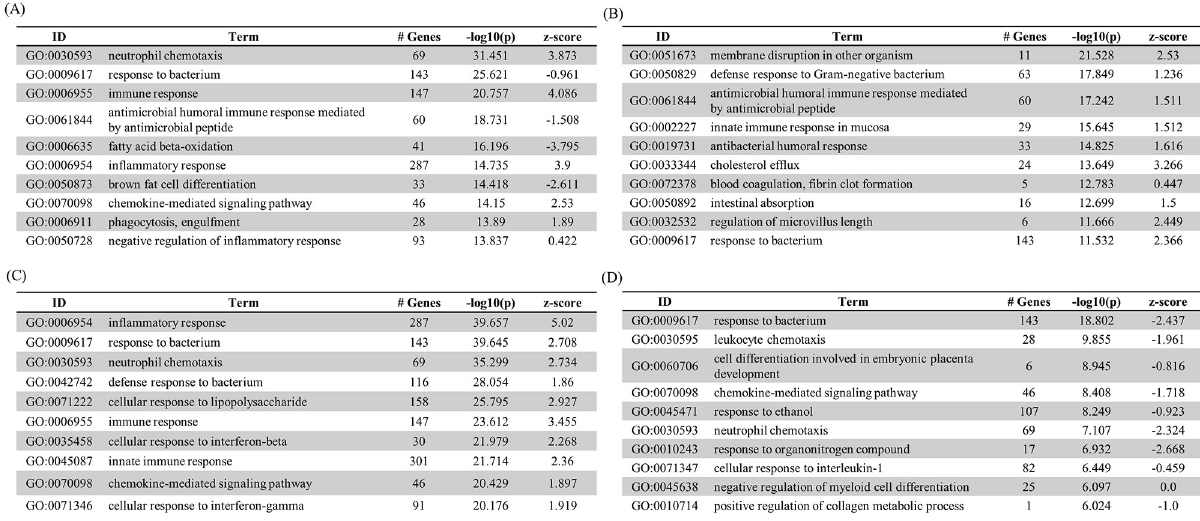
Fig 4. Top 10 Gene Ontology terms (biological process) of mice at 6 weeks of MAP infection. (A) MLN administered by the IP route, (B) MLN administered by the oral route, (C) spleen administered by the IP route, (D) spleen administered by the oral route.